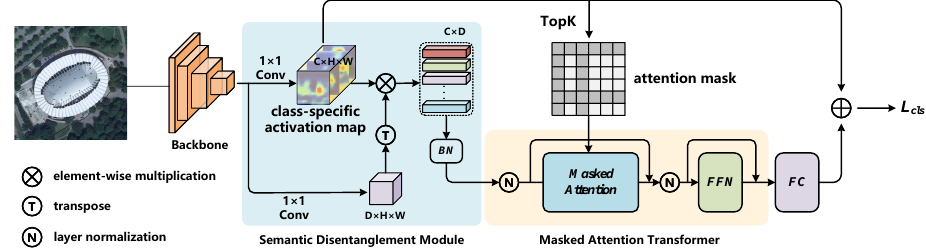
Figure 2. The overall framework of our proposed